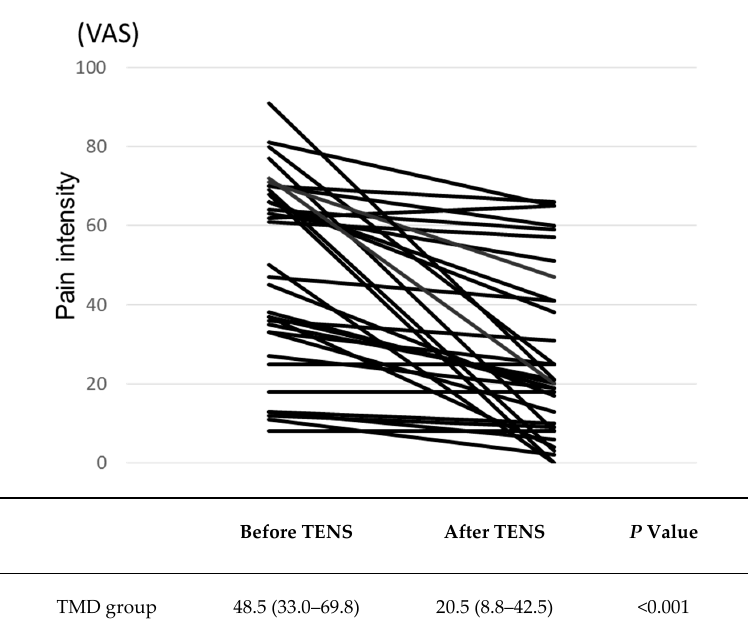
Figure 2. Changes in pain intensity before and after transcutaneous electrical nerve stimulation (TENS) treatment. Data are the Median (IQR: first quartile–third quartile). There was a significant decrease in the mean visual analog scale (VAS) value after the TENS treatment (Wilcoxon signed rank sum test).